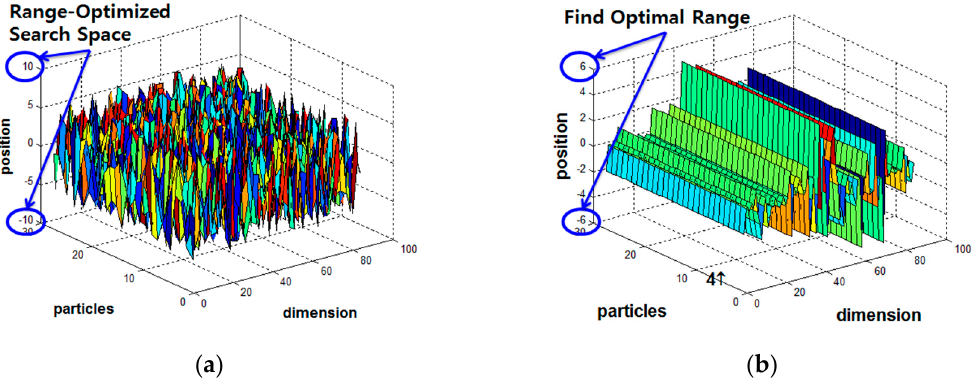
Figure 4. A hybridization of PSOpid, LM and PSO, namely PSOpid-LM-PSO: ( a ) initial position of particles within a shrunk hypercube; and ( b ) convergence position of the particles.